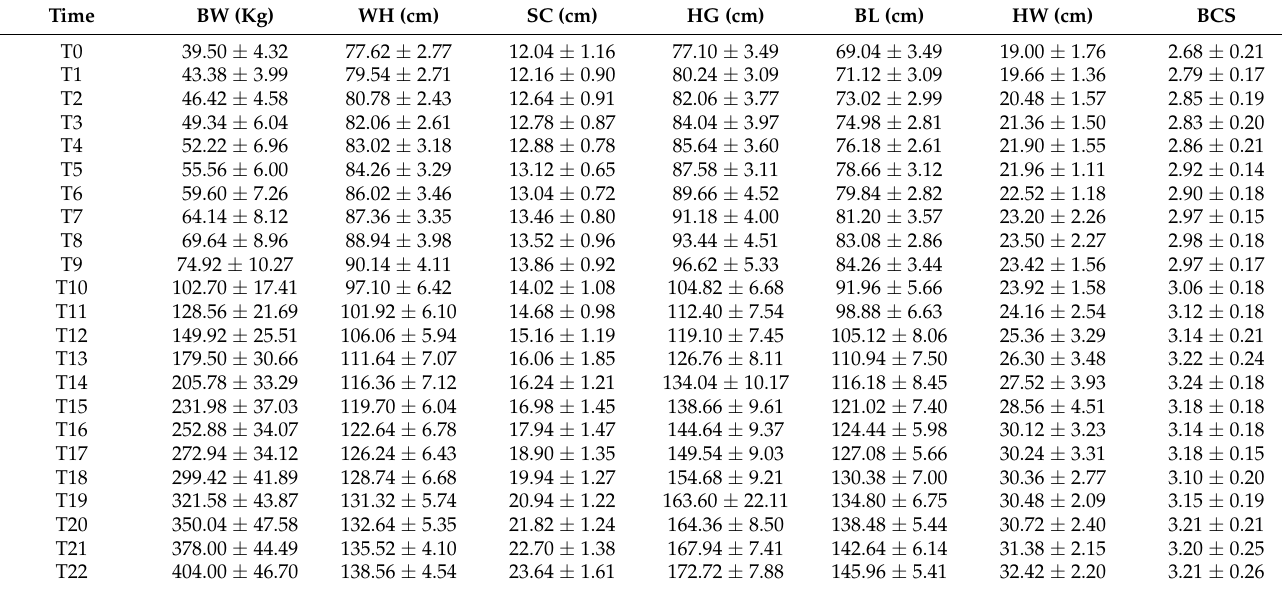
Table 1. Mean ± standard deviation of body weight, body measurements and body condition score evaluated in 25 rearing Holstein heifers at different times